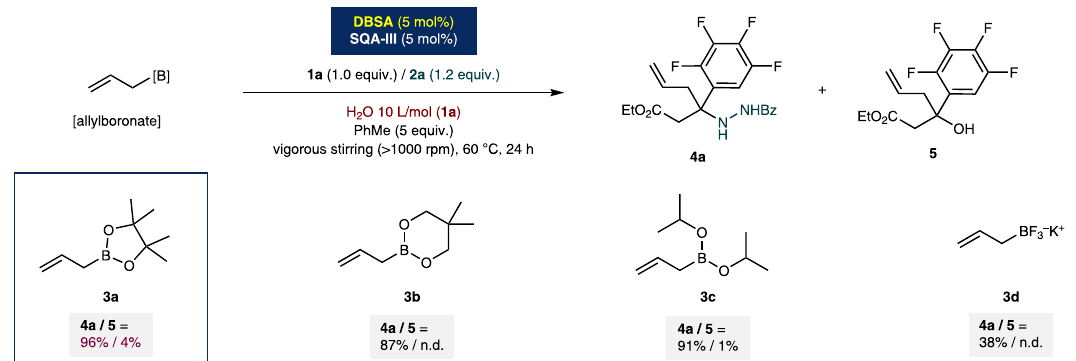
Fig. 3 Detailed study on the allylboronates. a Conditions: Reactions were performed with ketone 1a (0.2 mmol), benzhydrazide 2a (1.2 equiv.), allylboronate (1.5 equiv.) and set of catalysts (5.0 mol%) with water (2.0 mL: 10 L/mol ( 1a )) and PhMe (5.0 equiv.) at 60 °C for 24 h. b Yields were determined by 1 H NMR analysis using 1,3,5-trimethoxybenzene as internal standard. c n.d. = not detected. Bz = benzoyl; Et